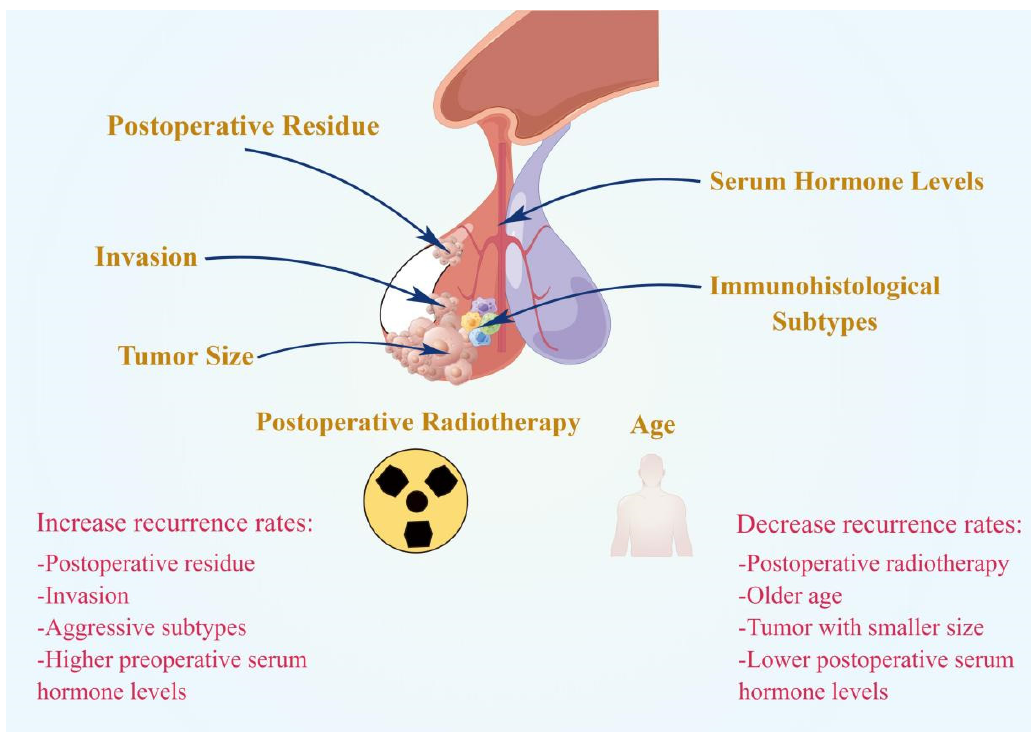
Figure 1. Summary of clinical prognostic factors for PA recurrence. Postoperative residue, invasion, aggressive subtypes, and higher preoperative serum hormone levels could promote the recurrence of PAs. Whereas postoperative radiotherapy, older age, smaller tumor size, and lower postoperative serum hormone levels could inhibit the recurrence of PAs.